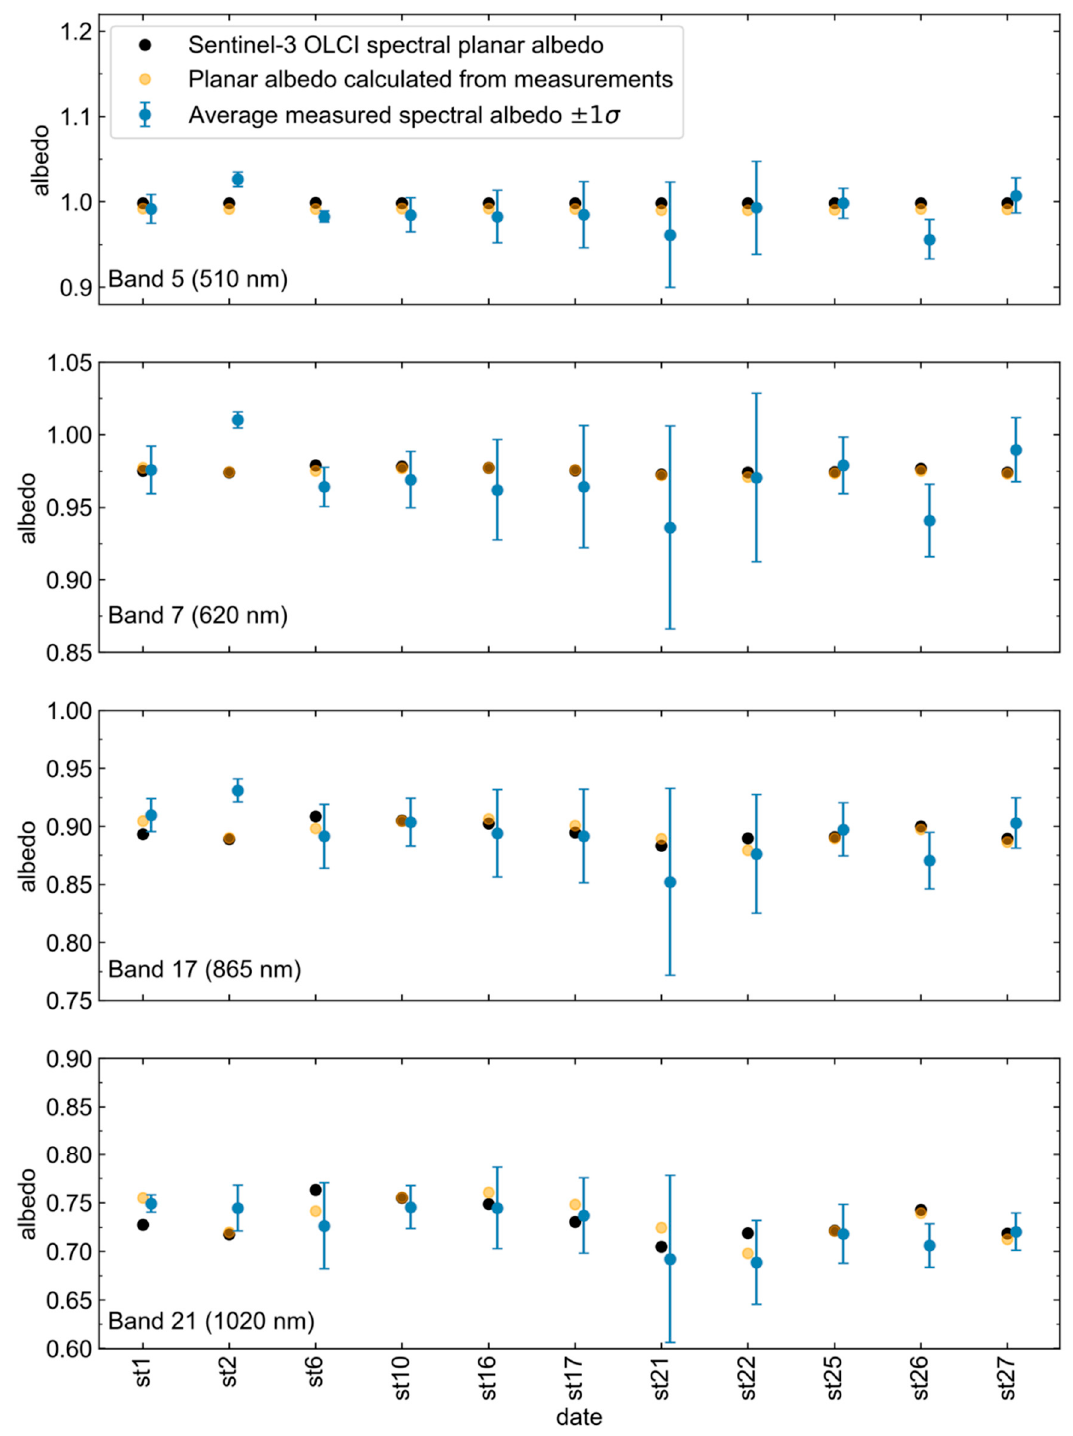
Figure 11. Comparison of the retrieved Sentinel-3 OLCI spectral planar albedo and the measured albedo for the sites along the ASUMA transect in Antarctica. The error bars of the spatialised measurements at each site are an indicator of the sub-pixel variability. The orange markers represent the planar albedo calculated using the field measurements for the SZA at the time of the satellite acquisition.